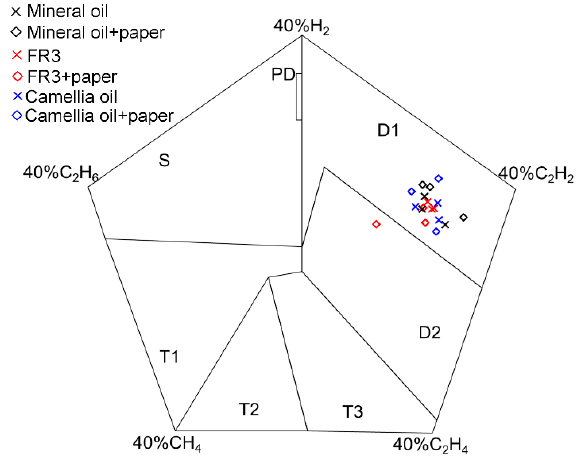
Figure 19. Diagnostic results of simulated electrical faults using the Duval Pentagon.